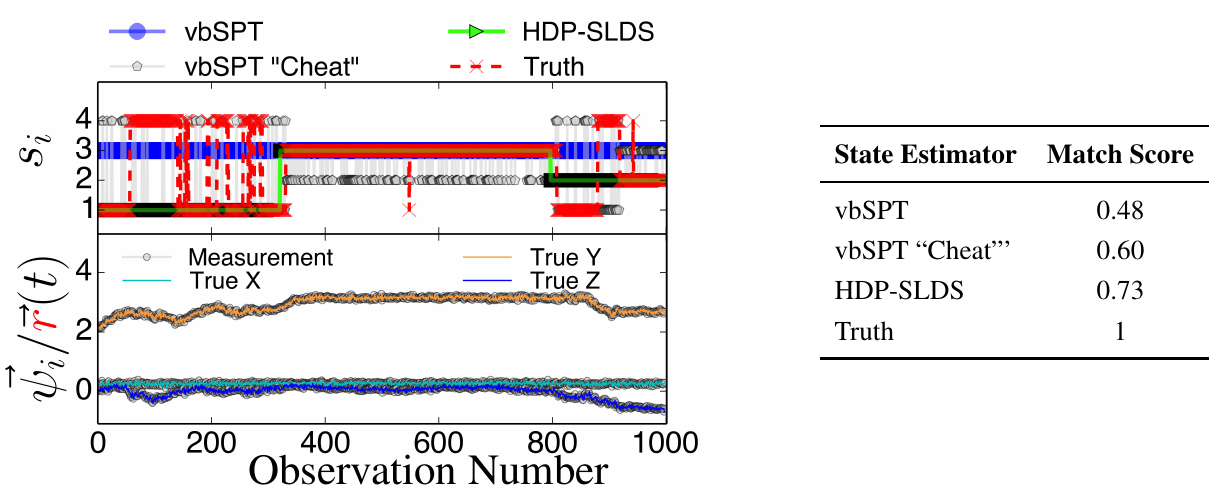
Figure 4. Same as Figure 3 except a new trajectory is analyzed where a different sequence of states is